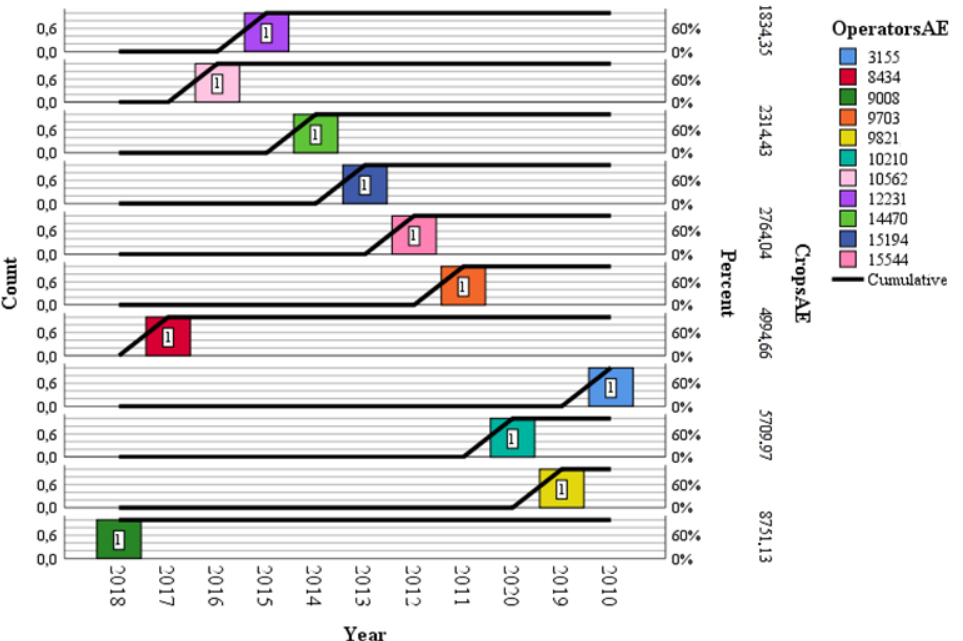
Figure 6. Pareto diagram of the evolution of the dependent variable OperatorsAE in relation to the variable CropsAE. Source: Elaborated by the authors.